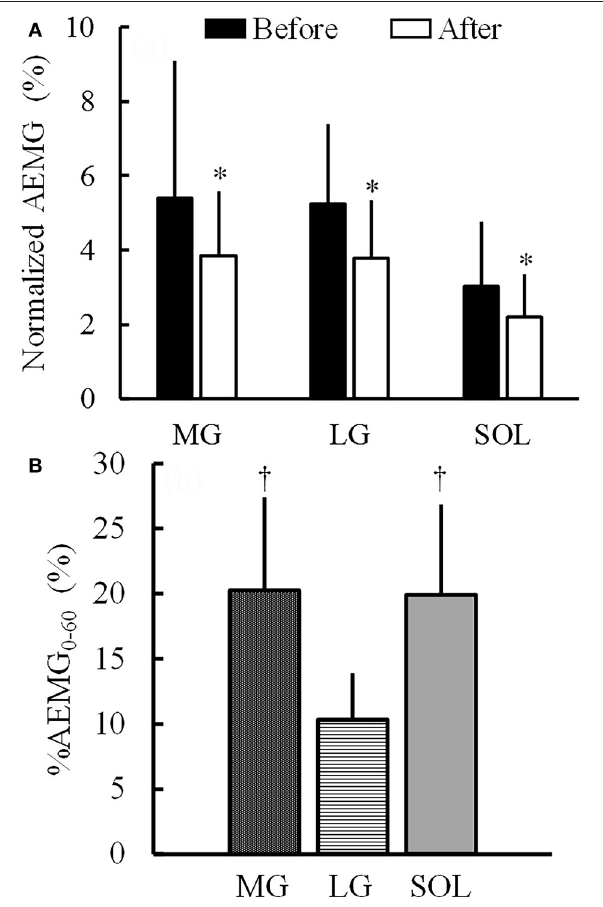
FIGURE 7 | Average electromyographic signal (AEMG) during the maximal voluntary contraction normalized by the peak-to-peak compound muscle action potential amplitude (A) and AEMG during the 1-h fatiguing task normalized by AEMG in the maximal voluntary contraction task before the 1-h fatiguing task (%AEMG 0 − 60 ) (B) ( n = 16). MG, the medial gastrocnemius muscle; LG, the lateral gastrocnemius muscle; SOL, the soleus muscle. *Indicates the significant main effect of time (before and after the 1-h fatiguing task) ( P < 0.05) without a significant time × muscle interaction. Regarding %AEMG 0 − 60 , there was a significant main effect of muscle. † Indicates the significant difference between MG or SOL and LG ( P <